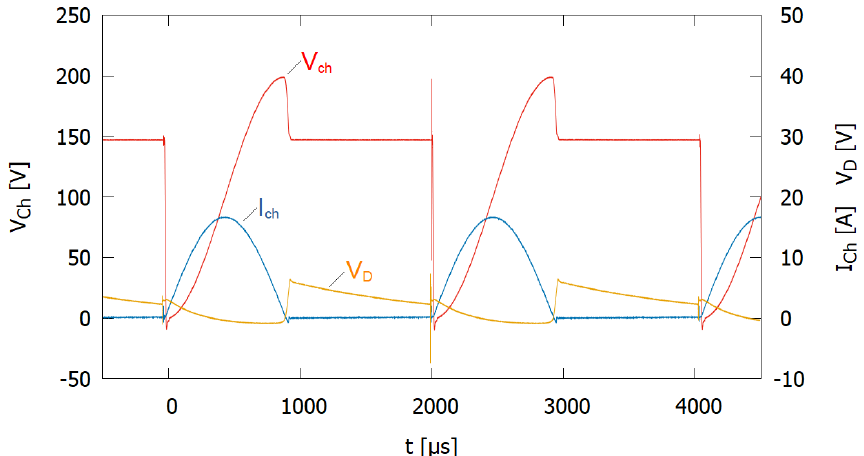
Figure 25. Measured charging voltage V ch and the charging current I ch at the charging input terminal of an 8-stage Marx generator with a diode in series to L Res , voltage V D across the damping resistor R D , on-time of the solid-state switches: 22 µs [10].